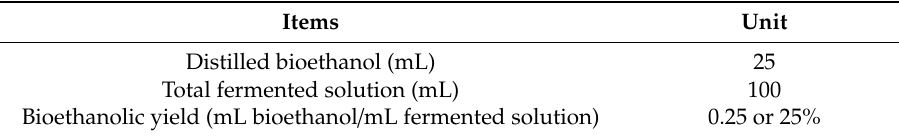
Table 4. Pure bioethanol by the distillation process. Items